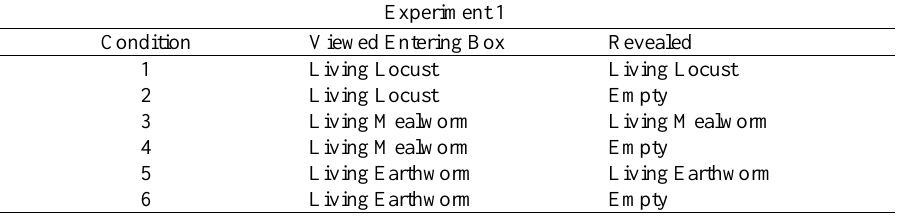
Congruent and Incongruent Conditions Presented in Experiment 1, Altering Insect